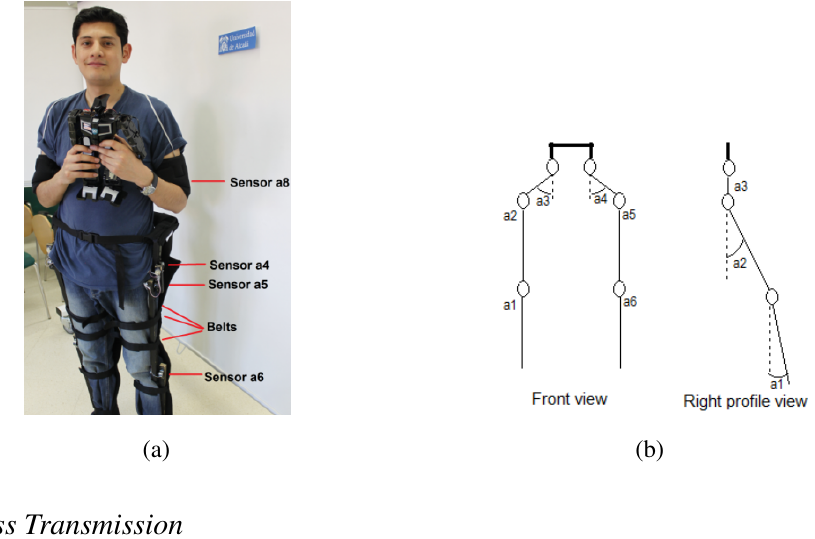
Figure 1. Teleoperator suit. ( a ) Suit on a person. ( b ) DoF of the